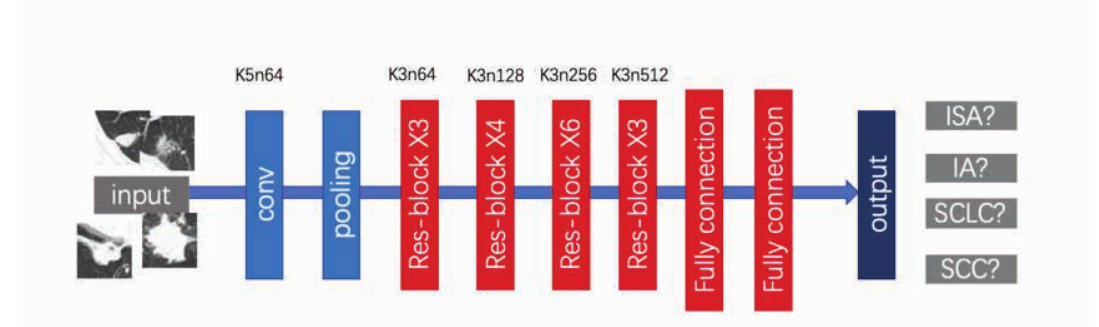
Figure 4: Architecture of our model which is based on residual blocks with corresponding kernel size, number of feature maps for each convolutional